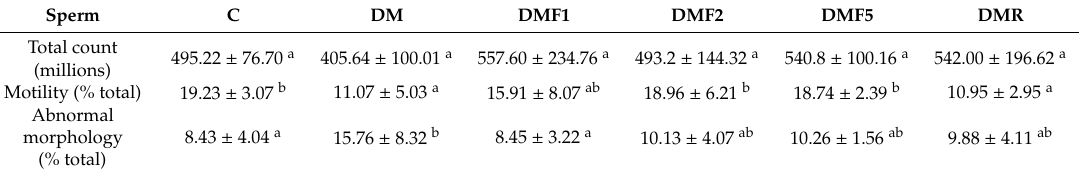
Table 5. E ff ects of fucoxanthin on rat sperm properties after treatment for four